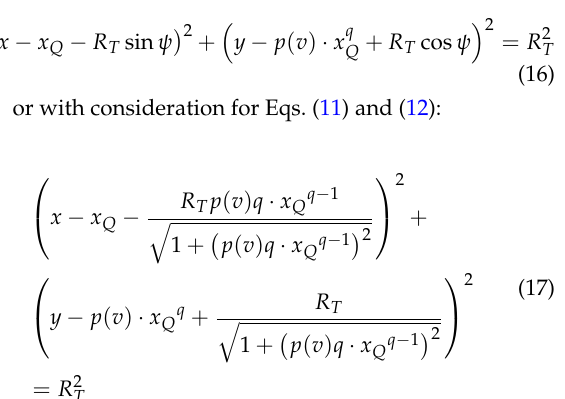
Fig. 4. Turn paths of kinematic center of wheeled vehicle